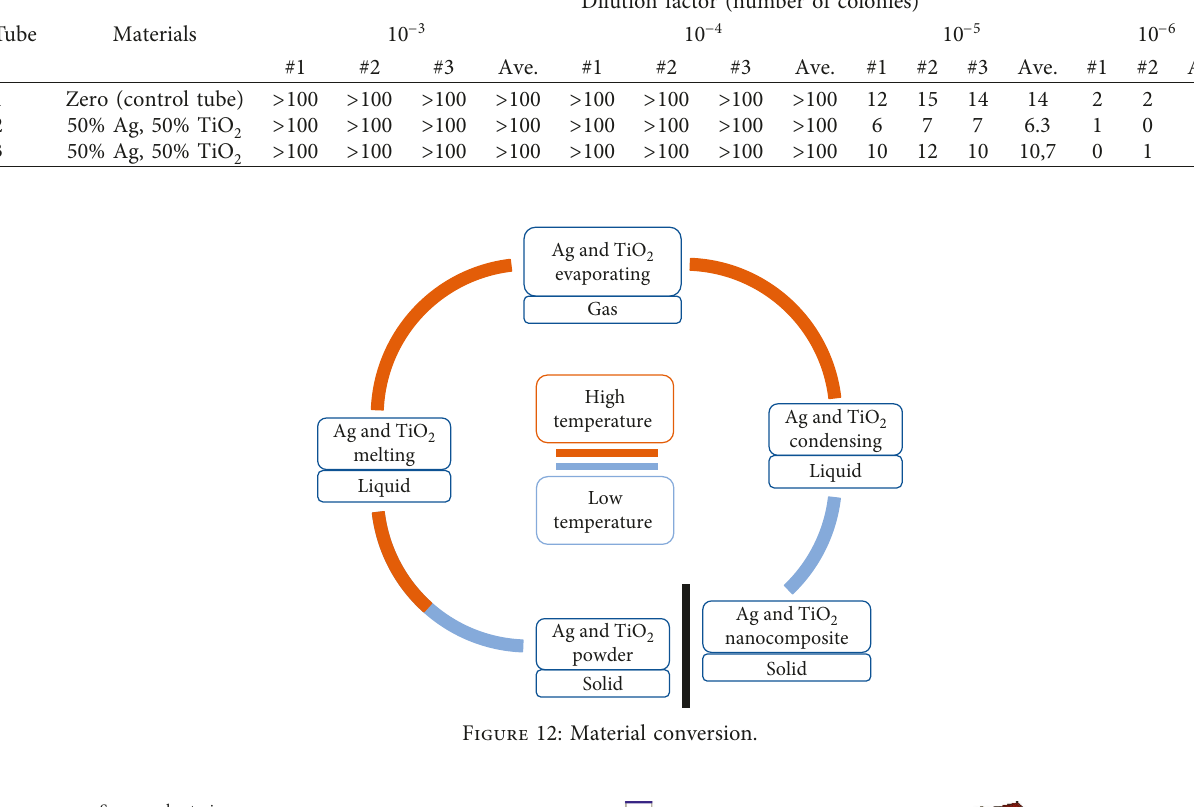
Table 4: The number of bacterial colonies for each setup, at each dilution factor. Tube